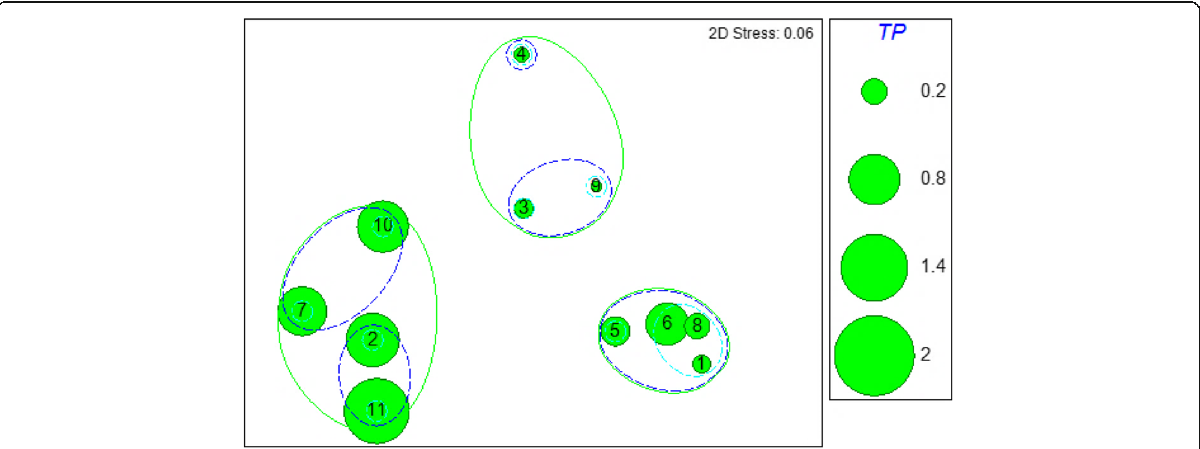
Fig. 5 NMDS plot of zooplankton abundance, with superimposed circles of increasing TP concentration. Numbers: 1 - Permaisuri, 2 - Intan Baiduri, 3 - Metropolitan, 4 - Biru Kundang, 5 - Titiwangsa, 6 - Batu, 7 - Desa Park, 8 - Jinjang, 9 - Sri Johor, 10 - Danau Kota, 11 - Selayang. Solid line: 45% similarity; dashed line: 50% similarity; dotted line: 65% similarity